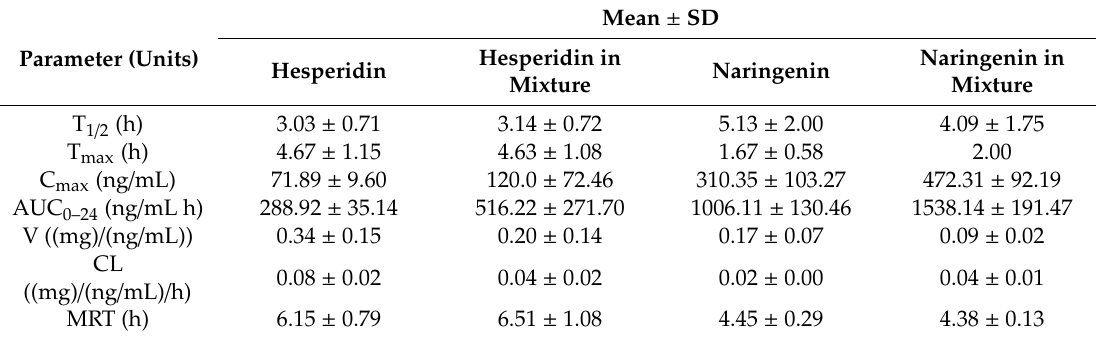
Table 4. Pharmacokinetic parameters of hesperidin, naringenin and both in a mixture by intragastric administration.